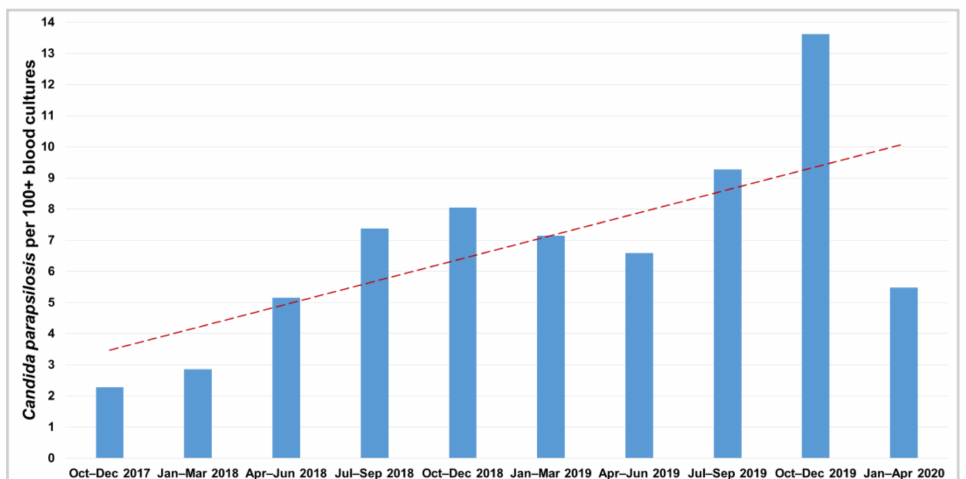
Figure 1. Candida parapsilosis isolates per 100 positive blood cultures at the cancer referral center. The red dashed trend line shows the marked increase from October 2017 to April 2020.